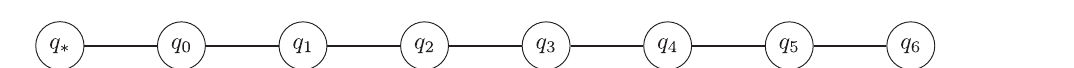
Fig. 1 Connectivity graph for qubits in our model. Each circle represents a qubit. Qubits connected by a solid line can have the Heisenberg interaction applied between them. The qubit q * can be prepared in the state | 0 〉 or | + 〉